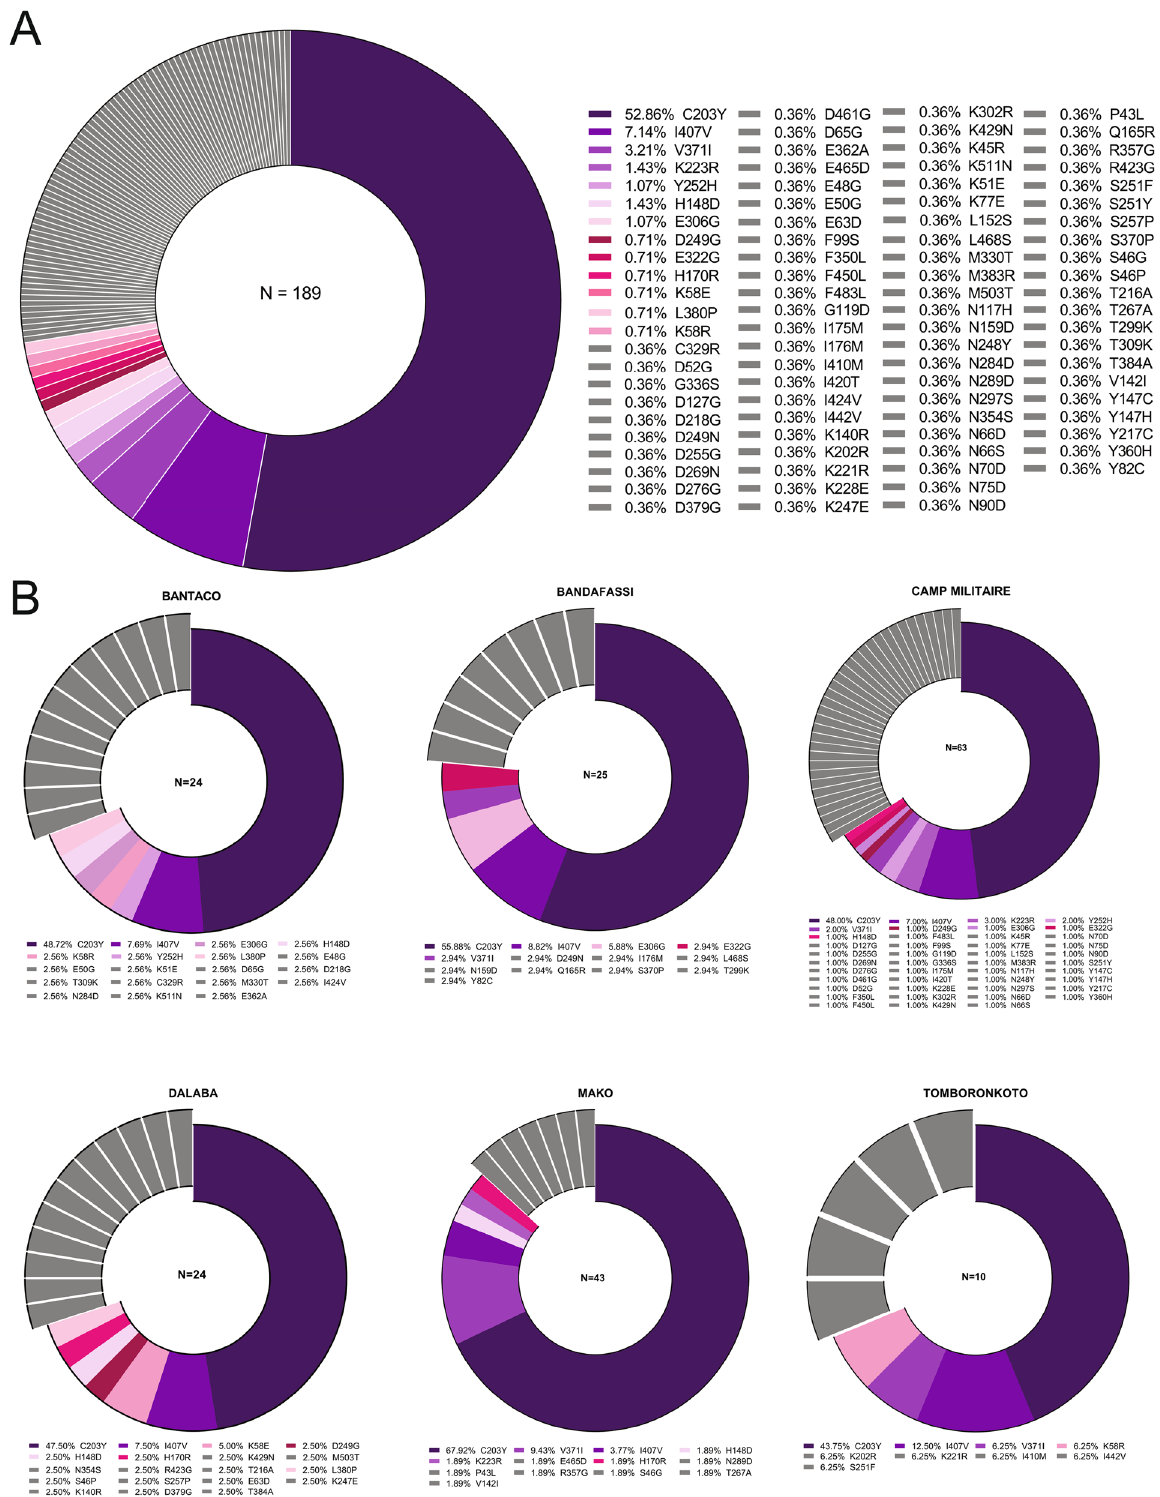
Figure 2. Population prevalence of known and novel SNPs in PfRh5. The prevalence of PfRh5-associated SNPs was calculated as the percentage of SNPs detected within the total sample population ( A ) or within site-specific sample populations ( B ) in Kédougou. The most prevalent SNPs, shared between two or more sites are depicted in degraded colors, while SNPs detected in individual isolates are depicted in grey ( A ). Exploded slices in ( B ) represent SNPs unique to the respective site, while the shared SNPs are shown in matched